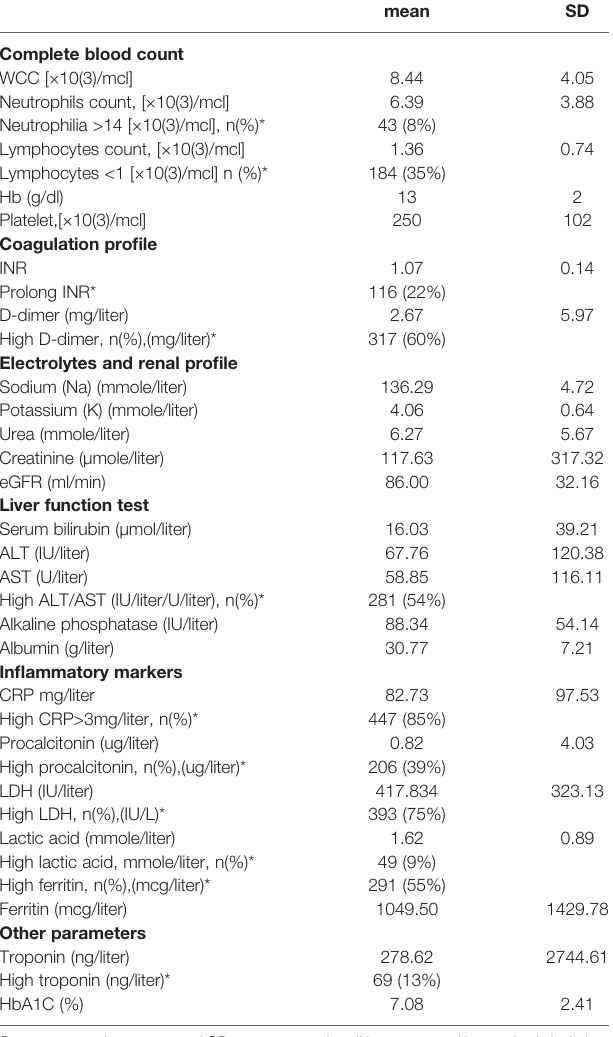
TABLE 4 | Laboratory features of 525 symptomatic COVID-19